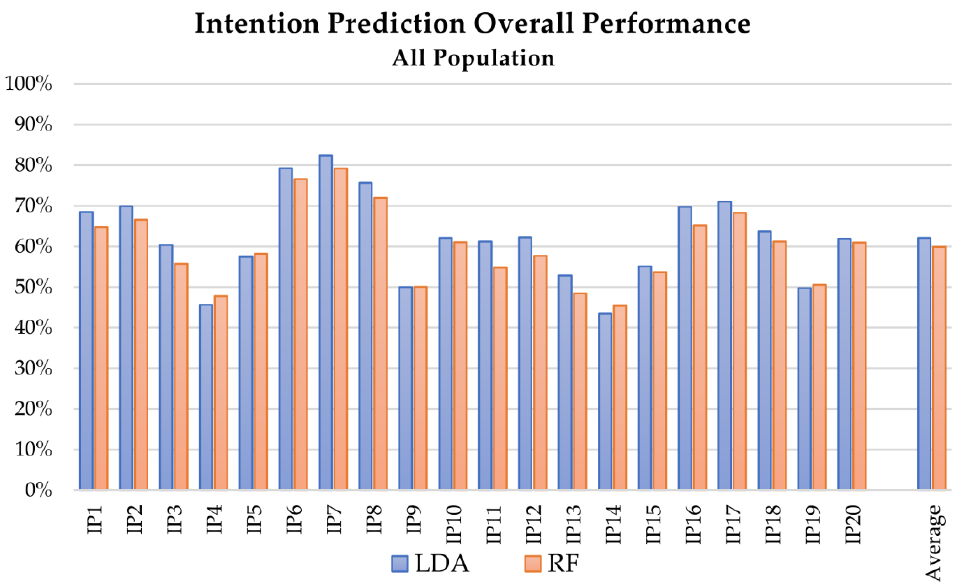
Figure 2. Mean accuracy of the intention prediction for the analysis of complete dataset (healthy and pathological subjects) with respect to the applied MLT: blue and red the results of the testing with LDA and RF, respectively.